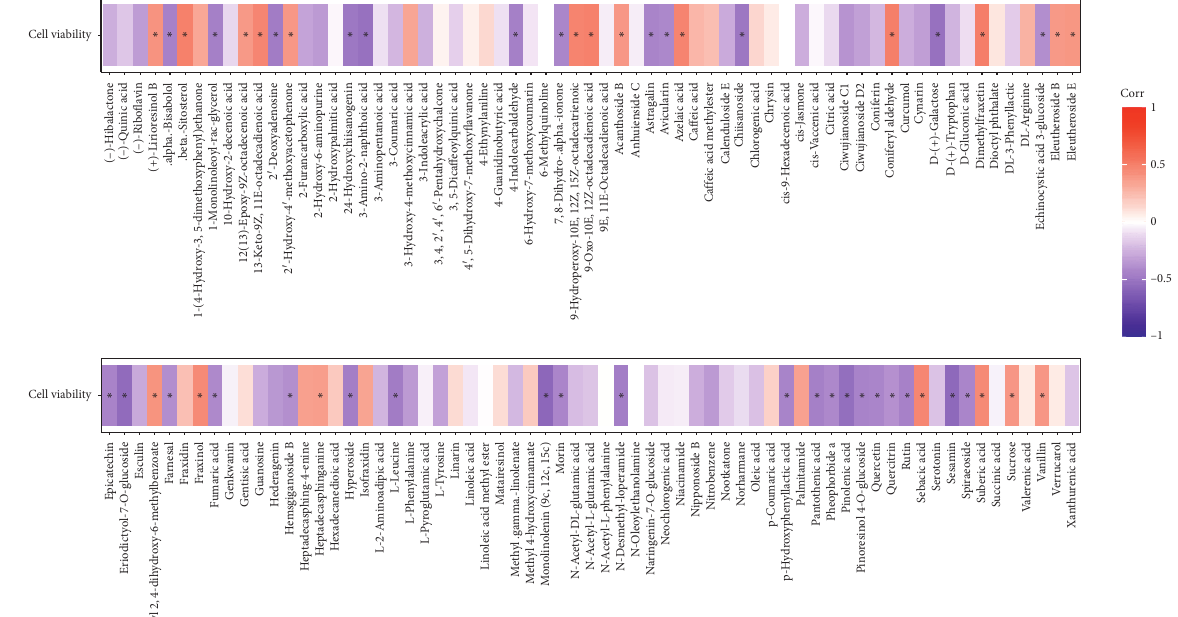
Figure 5: Correlation of different